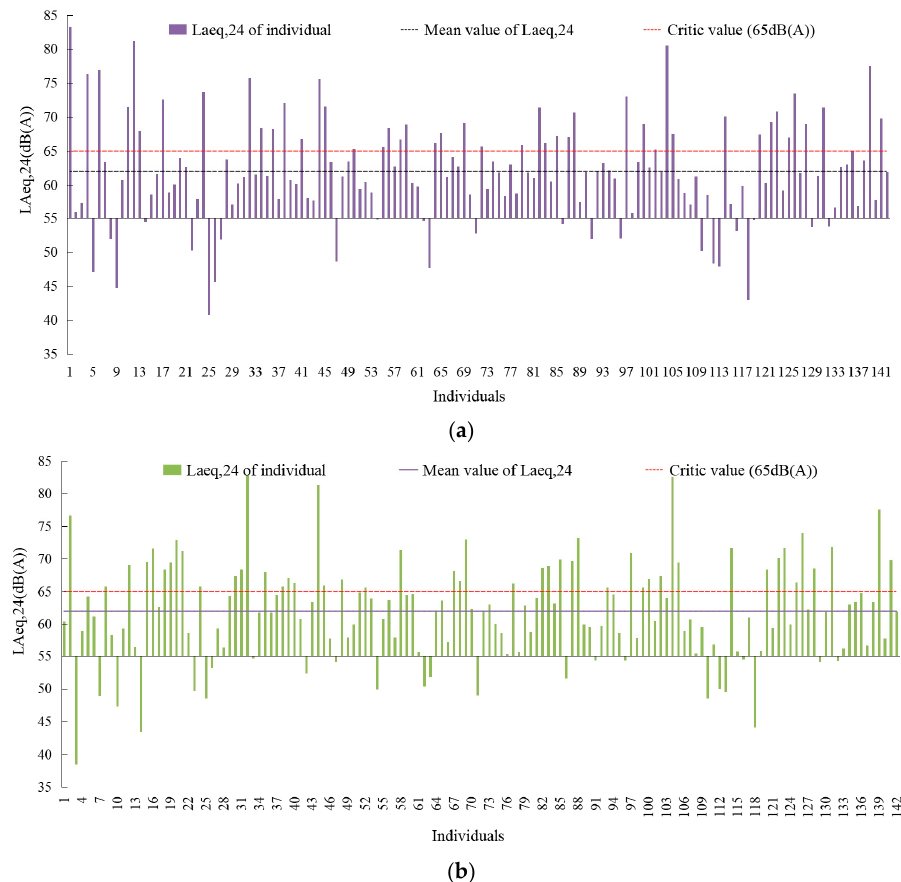
Figure 3. Environmental noise exposure values of residents on workdays and weekends. ( a ) Workday; ( b ) weekend.